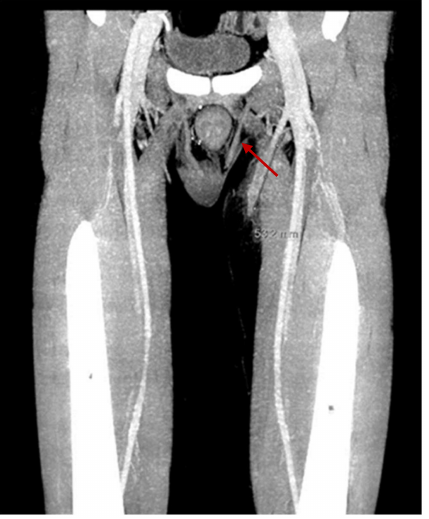
Figure 1. Superficial venous thrombosis in the great saphenous of the left lower limb with 5 cm extension, above the knee, up to 2 cm from the origin of the deep vein